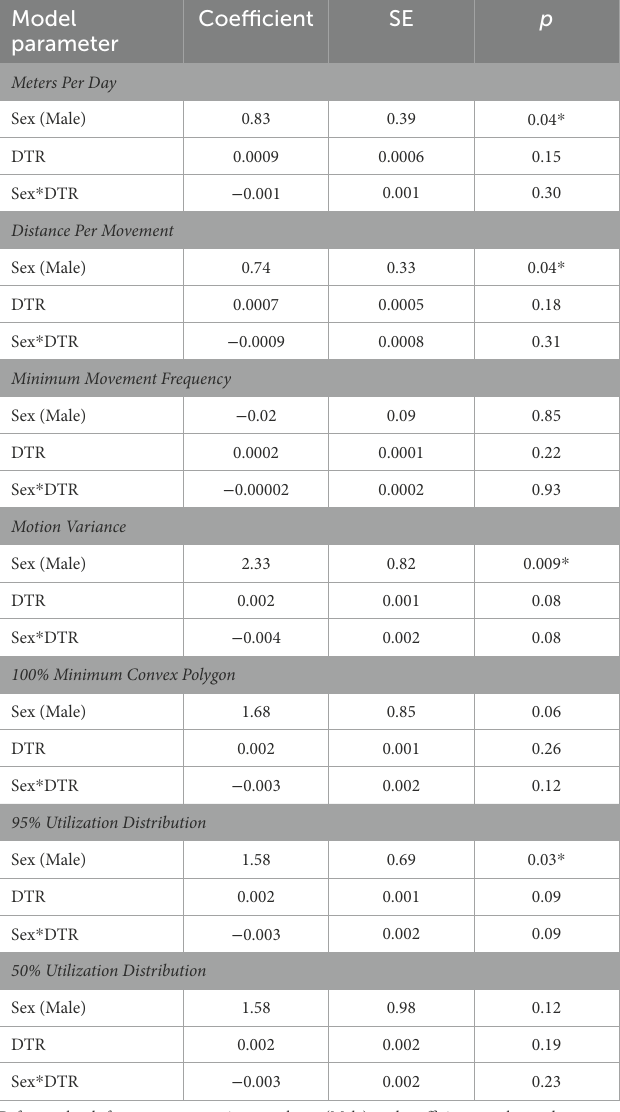
TABLE 2 Coefficients, standard error, and p -values for individual RT derived annual movement and space use model parameters.